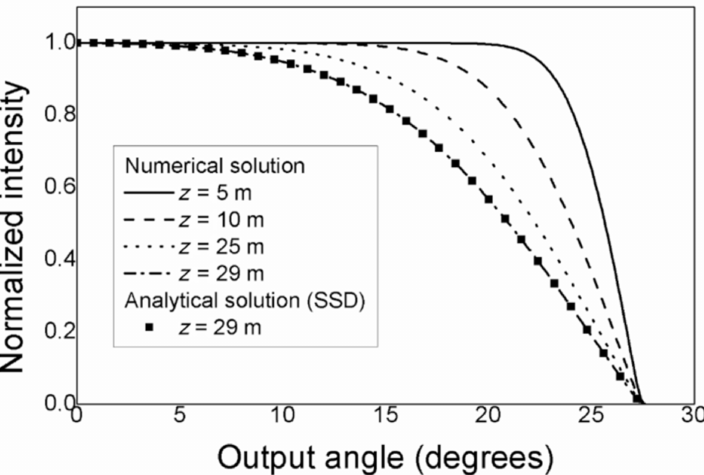
Figure 3. Normalized P ( θ , z ) along the CROFON fiber numerically calculated for Gaussian launch distribution centered at θ 0 = 0 ◦ with (FWHM) z =0 = 58 ◦ , at z = 5, 25 and 29 m ( (cid:110) represent the analytical SSD, Equation